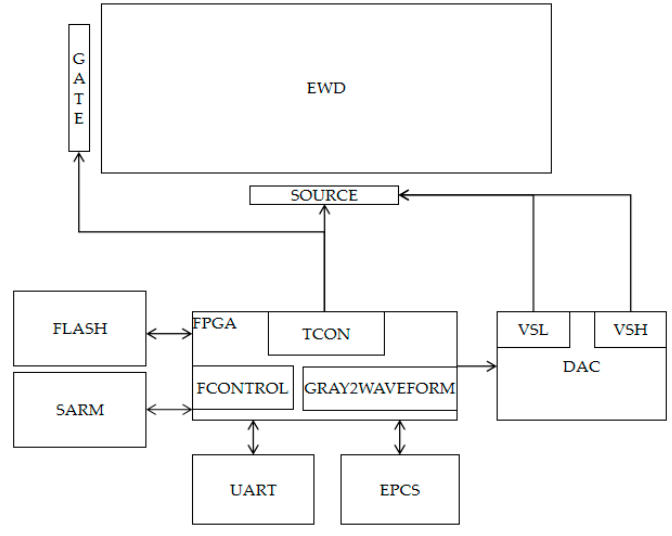
Figure 7. Driving system architecture of the TFT-EWD.